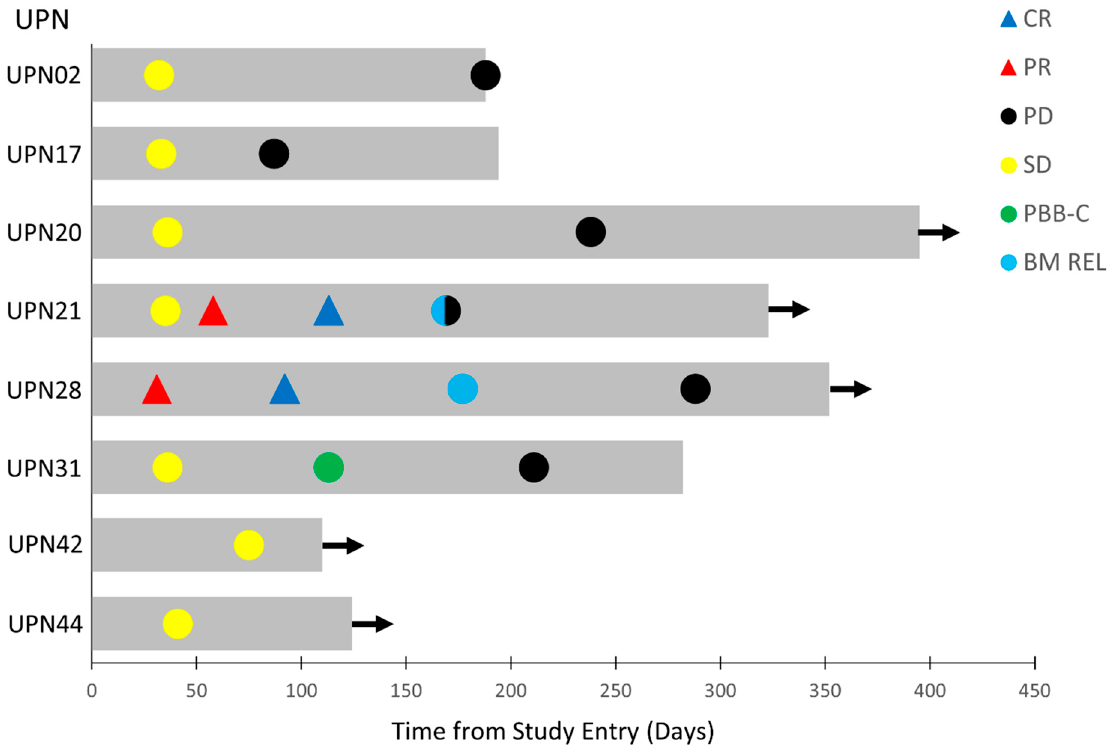
Figure 2. Swimmer plot of best overall responses of the eight-patient favorable response population of R/R AML patients. The onset and duration of SD, PR, CR, clearance of peripheral blasts (PBB-C), bone marrow relapse (BM REL), and onset of PD are indicated with specific symbols. Arrow: alive. See Table 4 and text for additional details.